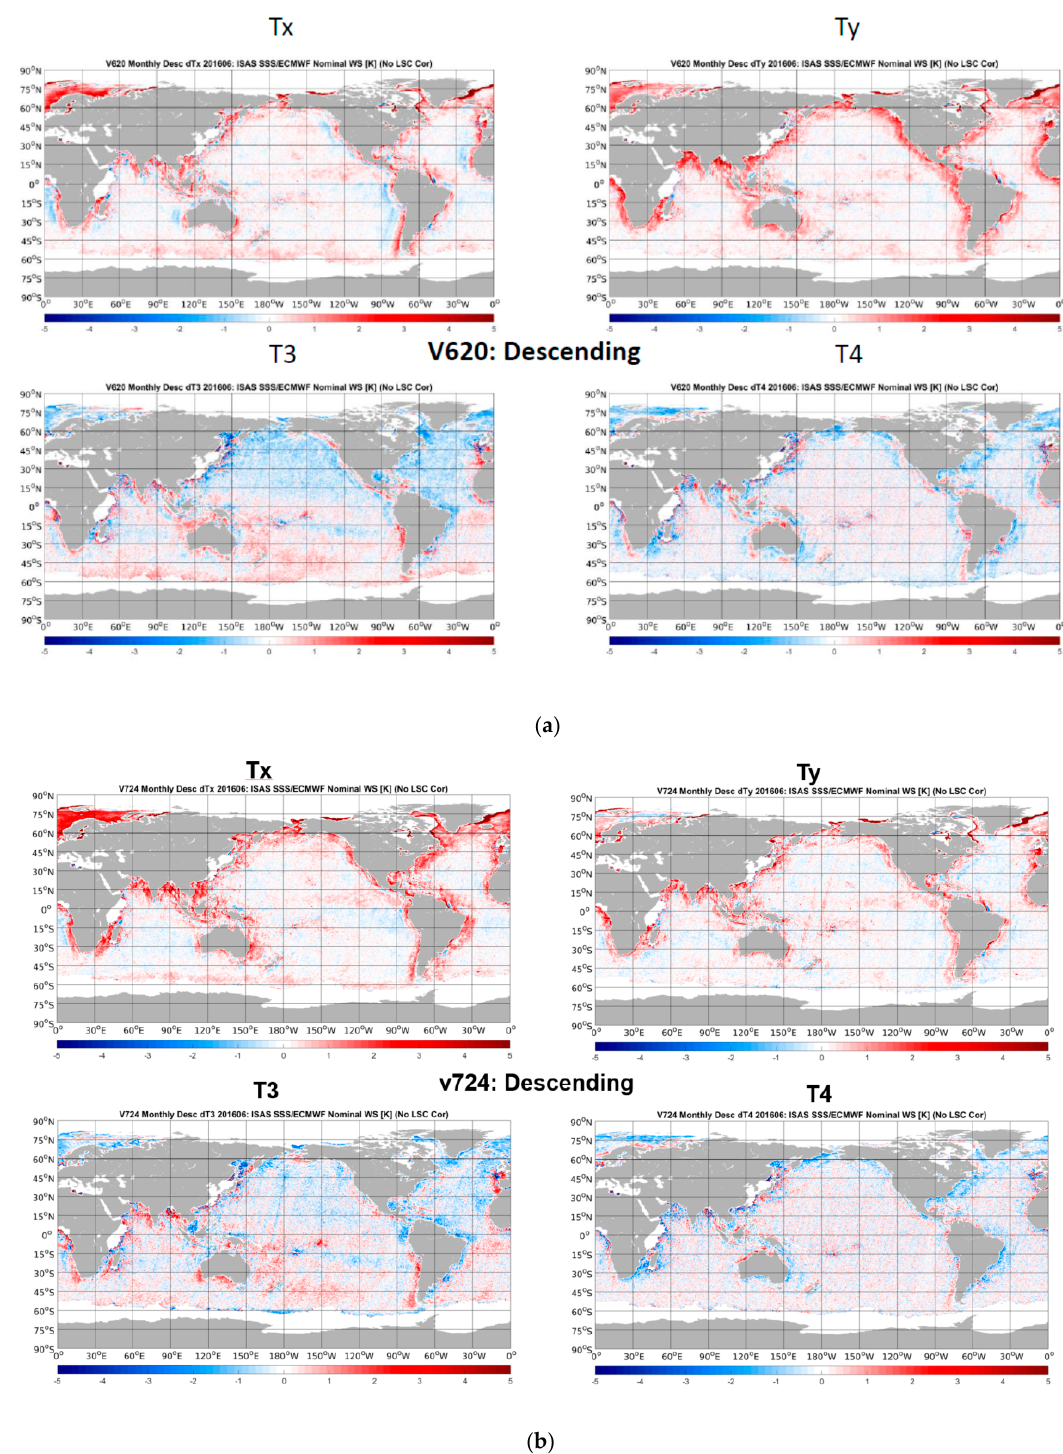
Figure 17. Maps of bias between SMOS measurements and the ocean forward model, showing an increase excess of bias in regions near the coast, known as land–sea contamination. ( a ) all four polarizations for v620 and ( b ) all four polarisations in v724.